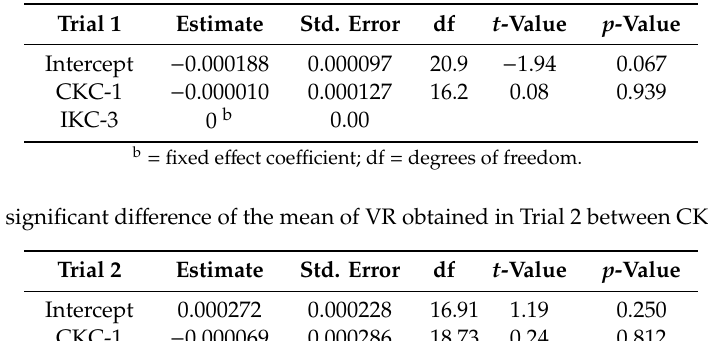
Table 11. The significant di ff erence of the mean of VR obtained in Trial 1 between CKC-1 and IKC-3. Trial 1 Estimate Std. Error df t -Value p -Value Intercept − 0.000188 0.000097 20.9 − 1.94 0.067 CKC-1 − 0.000010 0.000127 16.2 0.08 0.939